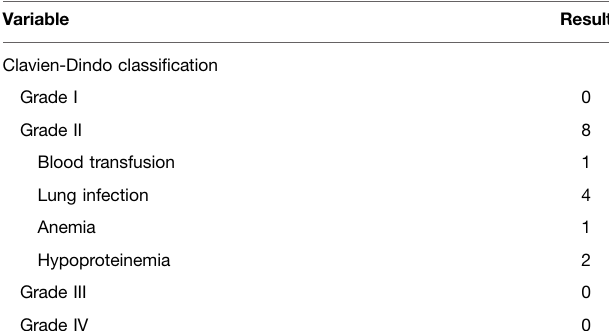
TABLE 3 | Postoperative complications.